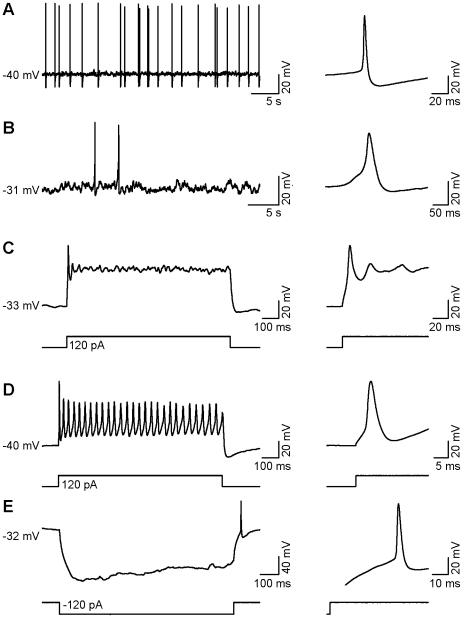
Whole-cell recordings from individual GFP+ TK23 cells in current-clamp mode.
A, B, Examples of spontaneous action potential activity and averaged waveforms from two different neurons. C, Example of an evoked single action potential and the same spike at higher temporal resolution. D, Example of multiple evoked action potentials and higher temporal resolution of the first action potential. E, A hyperpolarizing pulse showing a depolarizing sag followed by a single rebound action potential and the same action potential at higher temporal resolution.